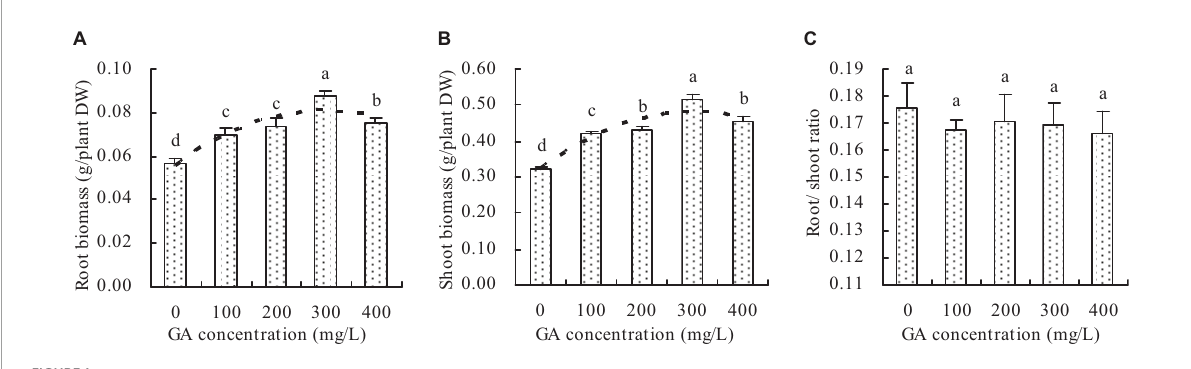
FIGURE1 Biomass of C . betacea . (A) Root biomass. (B) Shoot biomass. (C) Root/shoot ratio. Different lowercase letters indicate significant differences among the treatments (Duncan’s Multiple Range Test, P < 0.05).